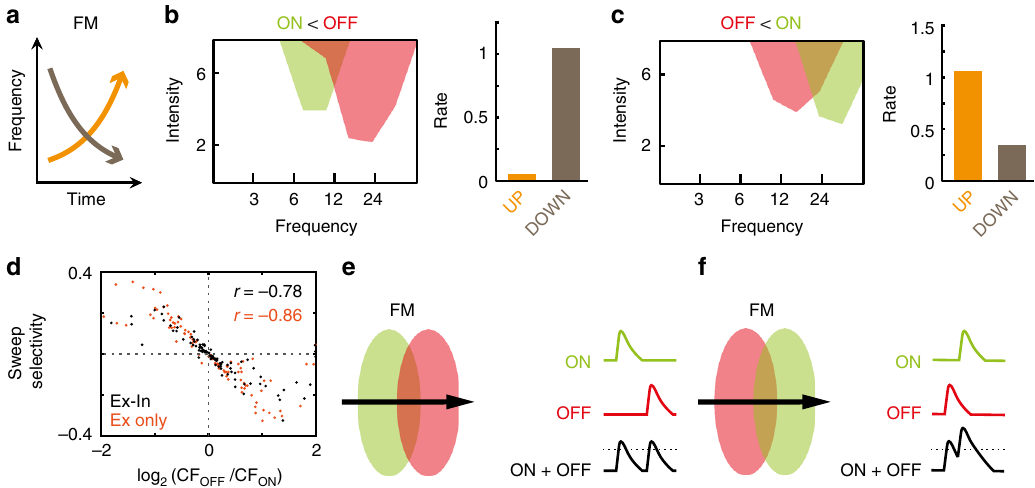
Fig. 4 Proposed functional signi fi cance of segregated ON and OFF RFs in A1. a Schematic of frequency-modulated (FM) sweep inputs. Modelled adult neurons are presented with either UP (orange) or DOWN (brown) FM sweeps. b Example model neuron ’ s FRA outline (left), where ON CF is at a lower frequency than OFF CF. Mean fi ring rate is greater for sweeps going DOWN rather than UP (right). c Same as b , but for example neuron where ON CF is at a higher frequency than OFF CF. In this case, the neuron prefers sweeps going UP. d Sweep selectivity as a function of ON/OFF CF difference for 100 cells in network with excitatory and inhibitory inputs (as in Fig. 2a; black dots), and excitatory-only network (as in Fig. 3c; orange dots). e – f Schematic of mechanism underlying sweep selectivity. e Example ON/OFF RF arrangement where ON RF (green ellipse) is selective for lower frequencies than OFF RF (red ellipse). When a FM sweep is going UP (black arrow), ON (green) and OFF (red) inputs are activated at different times. The sum of the inputs (black) is only just above the neuronal threshold (dashed black line). f Example ON/OFF RF arrangement where ON RF is selective for higher frequencies than OFF RF; when a FM sweep is going UP, OFF and ON inputs are activated in rapid succession and summate far above neuronal